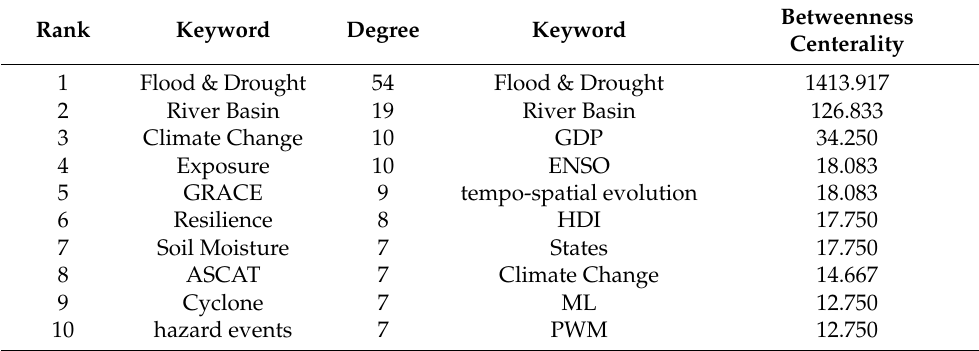
Figure 4. Clusters of methods and indices used in the literature to address both floods and droughts. Table 1. List of the top ten most important keywords in the network, with high degree (left) and high betweenness